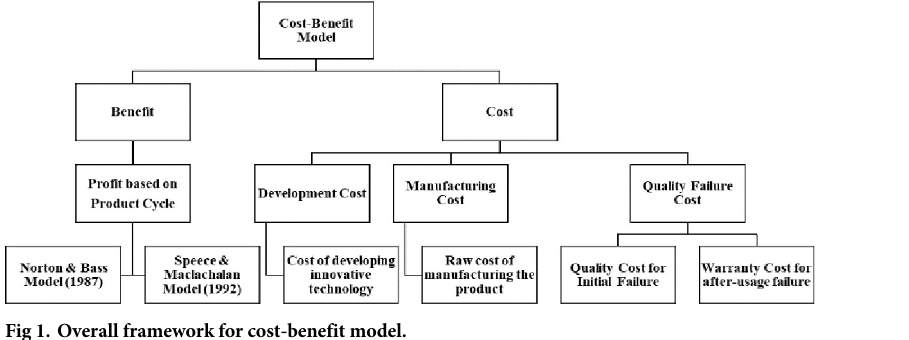
Fig 1. Overall framework for cost-benefit